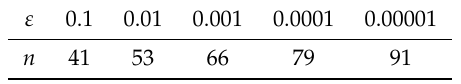
Table 2. Number n of iterations needed by the a priori estimate if stared with ( 100,20 ) .